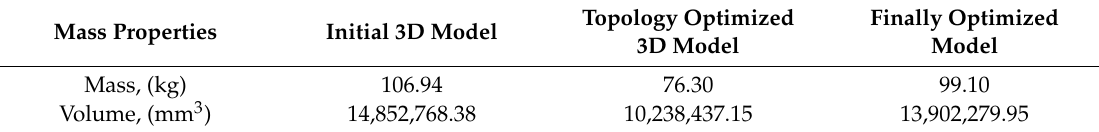
Table 4. Mass properties of the initial, the topology optimized, and the final optimized 3D models.